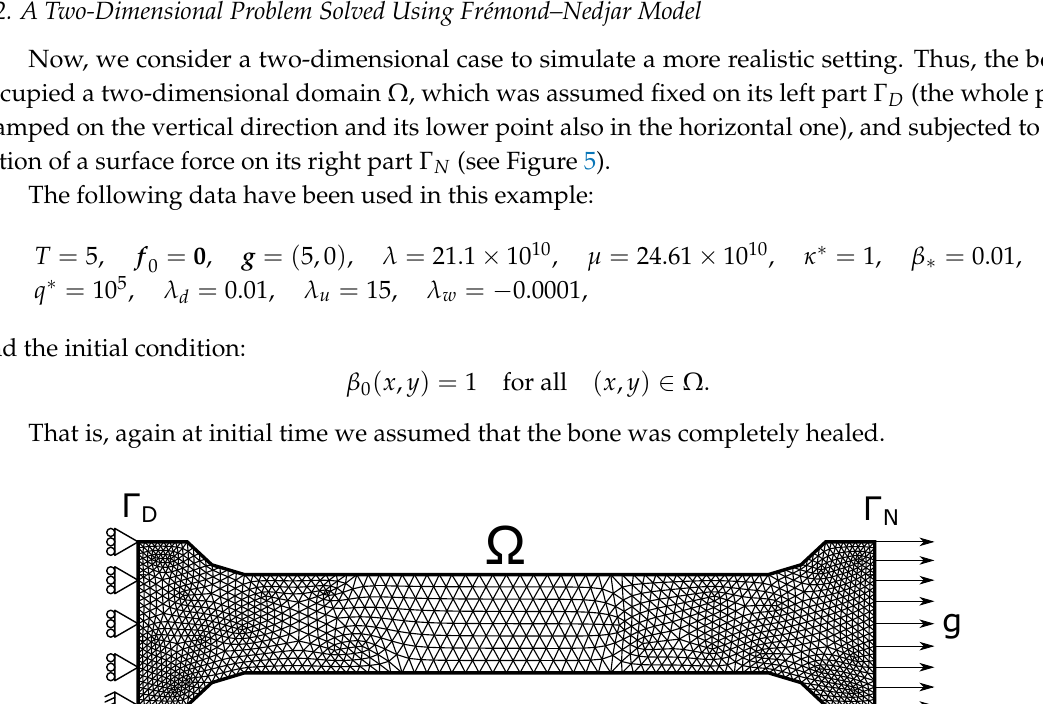
Figure 5. Physical settting and finite element mesh.